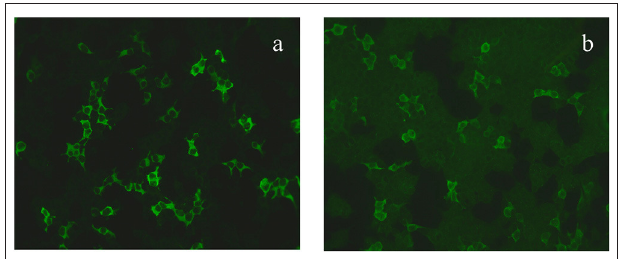
FIGURE 1 | The GAD65 antibody was diluted 1:10 in the serum (a) and 1:100 in the cerebrospinal fluid (b) .